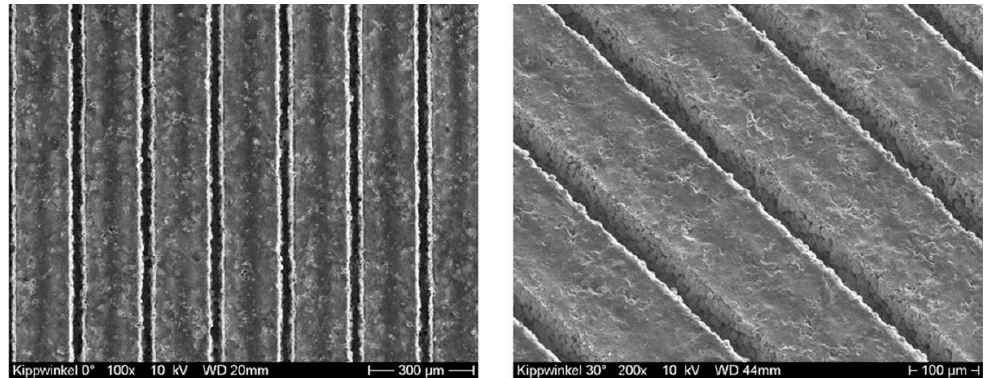
Figure 3. SEM images of laser structured NMC 622 cathodes with 200 µ m pitch distance and a film thickness of 91 µ thickness of 91 µm.